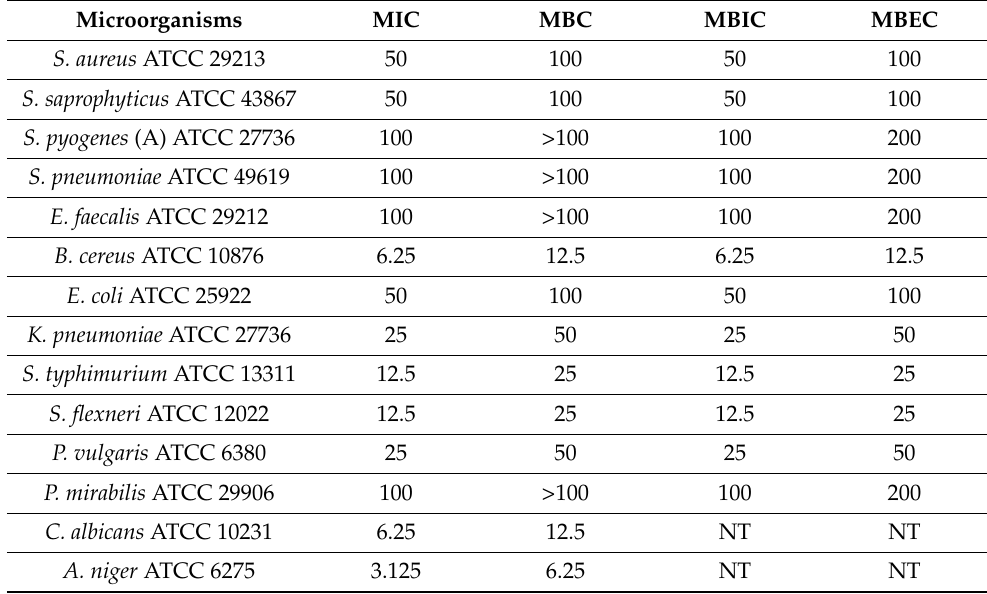
Table 4. Results of MIC, MBC, MBIC, and MBEC of ArJ essential